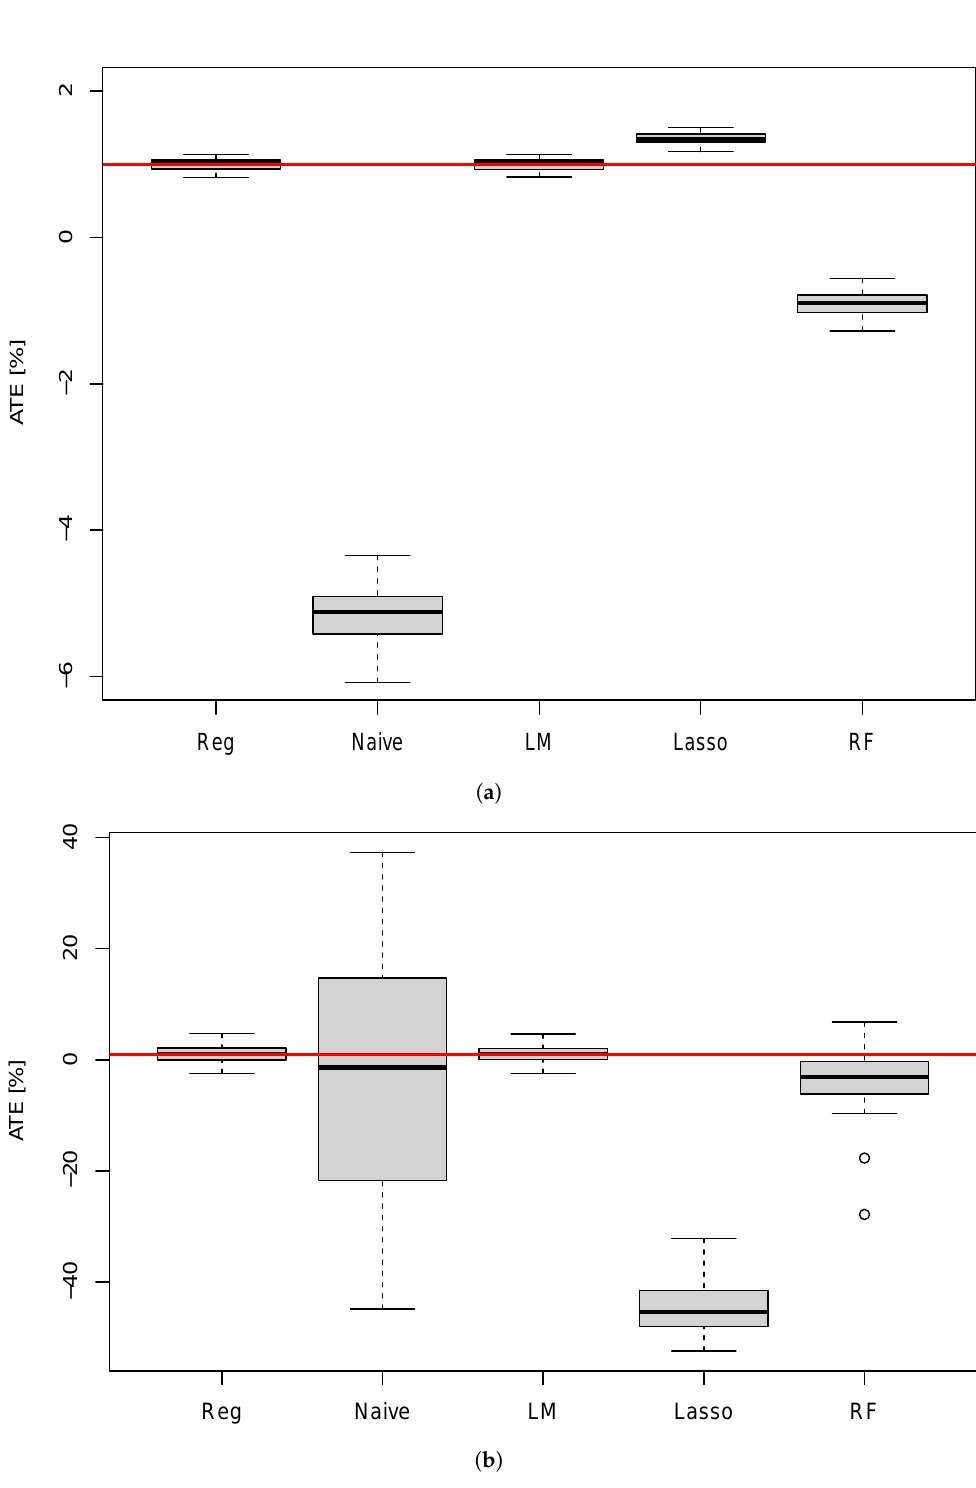
Figure 5. Box plots of the ATE estimations for the five methods where ATE true = 1. ( a ) linear. ( b ) non-linear. Mean, standard deviation, and t -test p -value results for ATE true = 50, are presented in Tables 2 and 3. The results show that the p -values for Reg and LM are not significant, indicating they are not statistically different from ATE true (95% confidence interval). This means they predict the true treatment effect well. However, the rest of the methods were statistically different ( p -value <